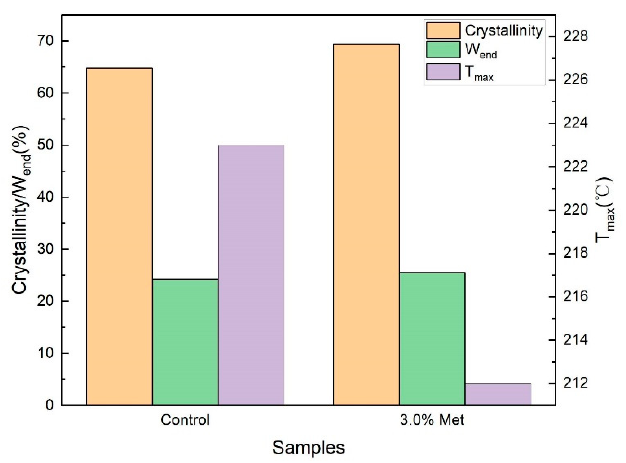
Figure 5. Crystallinity degree, W end , and T max of BC membranes. W end : the final weight loss rate of thermal degradation; T max : the temperature of maximum weight loss rate. Control: the BC membrane obtained in the FCW medium; 3.0% Met: the BC membrane obtained in the FCW medium with the addition of 3.0% methionine.